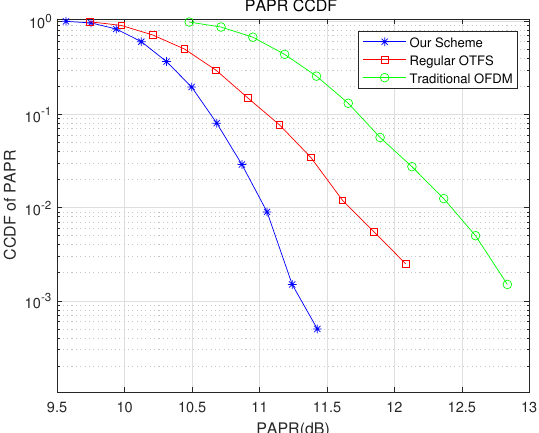
Figure 9. CCDF of PAPR for different